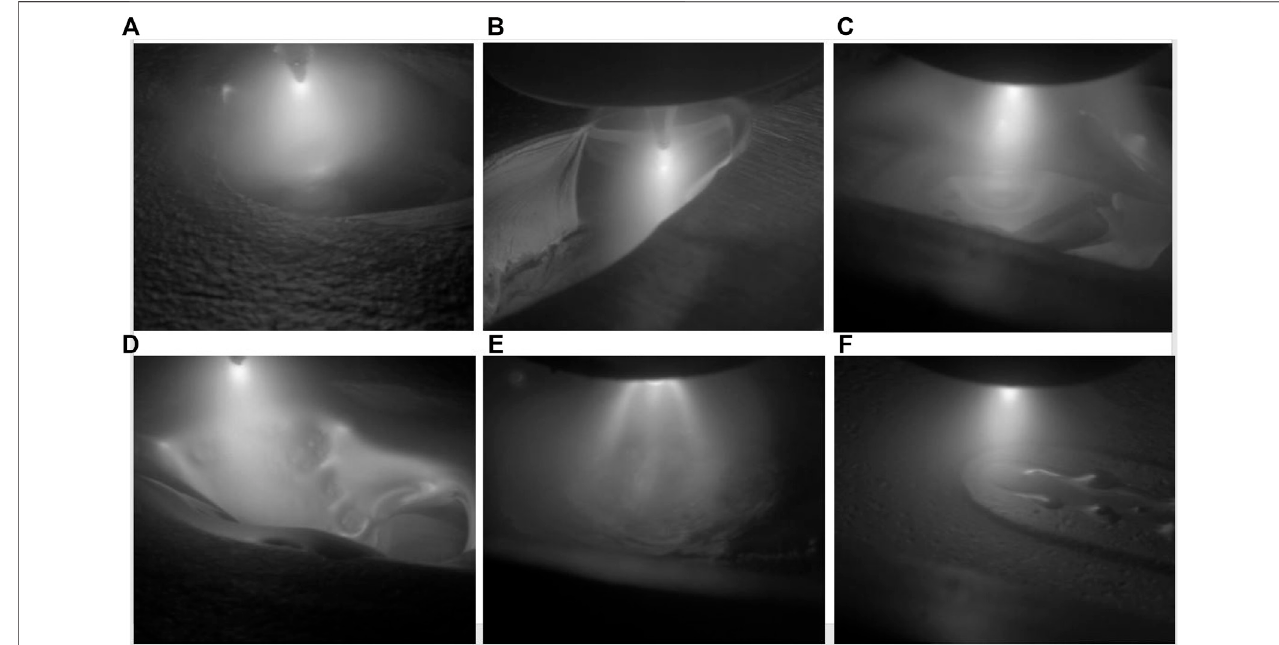
FIGURE1| TrainingsamplesofTIGweldingimages. (A) Goodweld, (B) burnthrough, (C) contamination, (D) lackoffusion, (E) lackofshieldinggas, (F) hightravel speed (Bacioiu, 2018).